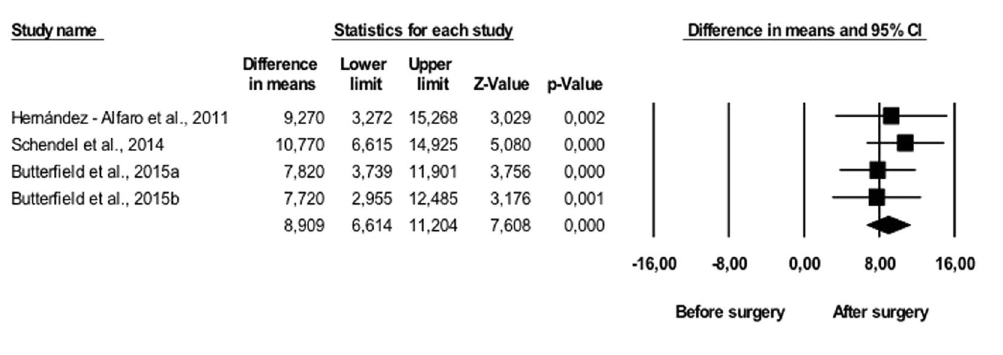
Figure 1. Changes in UA, vertical position (mm 3 ). Enlargement of upper airway following bimaxillary advancement surgery.